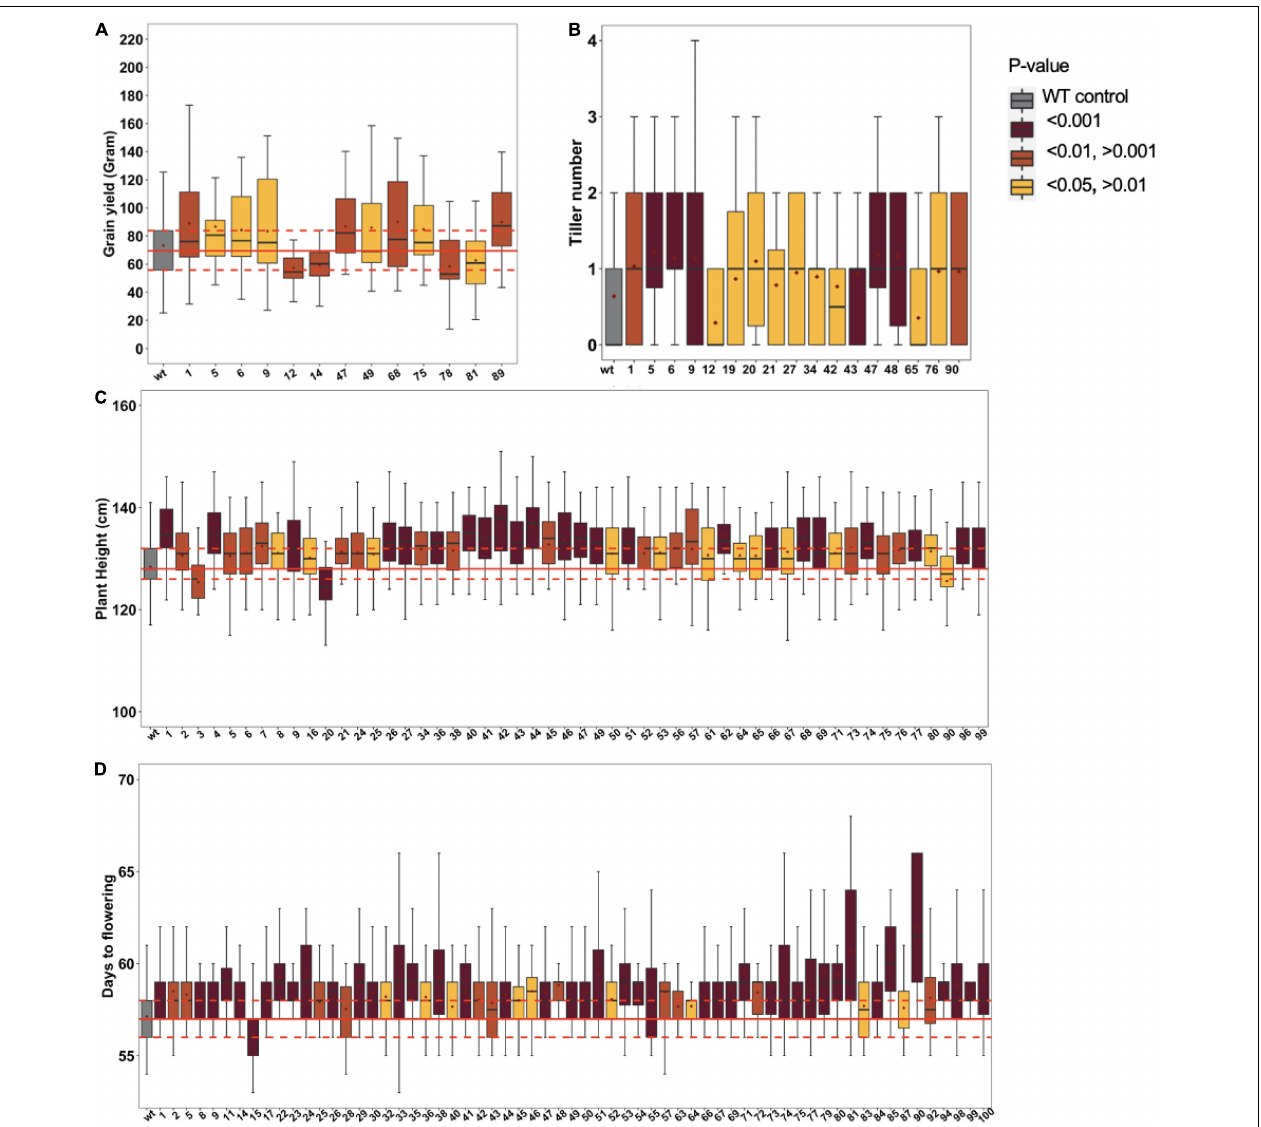
FIGURE 2 | Phenotypic variation in Epi-F2 lines. Boxplot diagrams of epi-F2 lines significantly different from wild-type Tx430 for (A) grain yield, where the least squares mean of each line was computed and a linear mixed-effect model was used for pairwise comparisons between each F2 line and the wild type; (B) tiller number, where the least squares mean of each line was computed and a Poisson model with log link was used for pairwise comparisons between each F2 line and the wild type; (C) plant height, where the least squares mean of each line was computed and a linear mixed-effect model was used to make pairwise comparisons between each F2 line and the wild type; and (D) days to flowering, where the least squares mean of each line was computed and a GAMMA model was used to make pairwise comparisons between each F2 line and the wild type. WT data are from 6650 Tx430 WT plants and 4502 Tx430 WT × Tx430 WT F2 plants. We pooled the Tx430 WT and Tx430 WT × Tx430 WT F2 data, since there was no significant difference between the two types of controls. Epi-F2 data are from the progeny derived from multiple individual WT crosses to msh1 Epi-F1